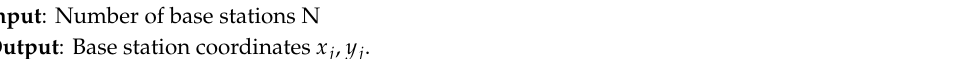
Algorithm A1: Semi-autonomous calculation process of coordinates of unknown base